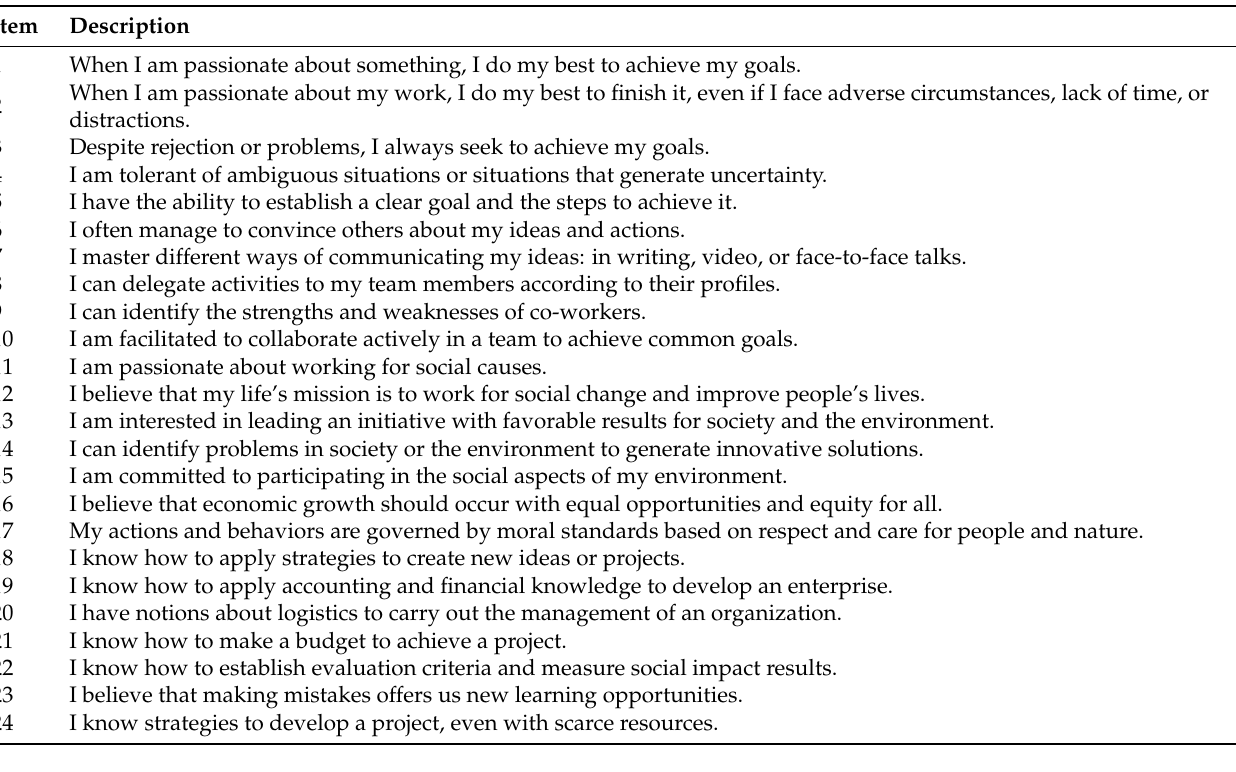
Table 1. Entrepreneurial profile instrument